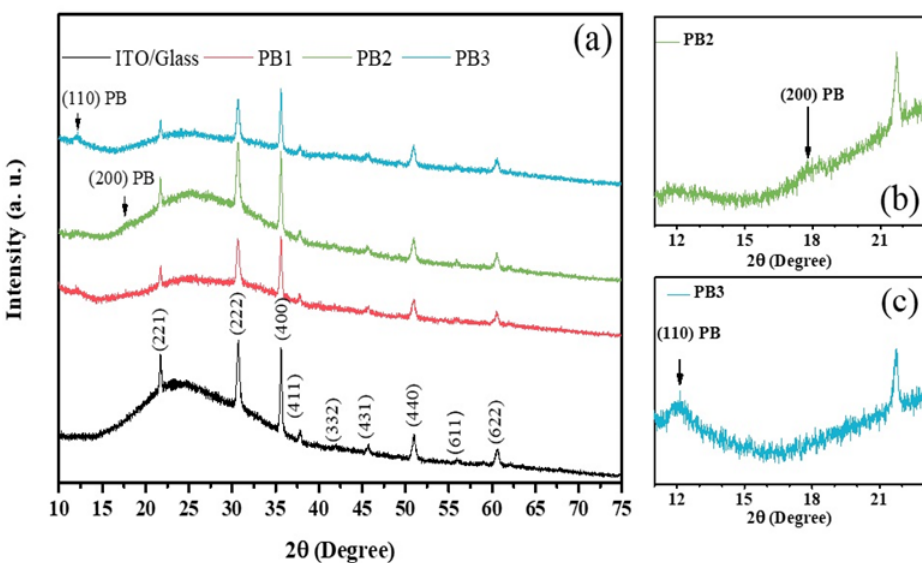
Figure 5. X-ray diffraction (XRD) patterns of the ( a ) PB films prepared over ITO/Glass substrates, along with the corresponding diffractogram obtained in an ITO/Glass sample. In ( b , c ) are the XRD patterns for samples ( b ) PB2 and ( c ) PB3.